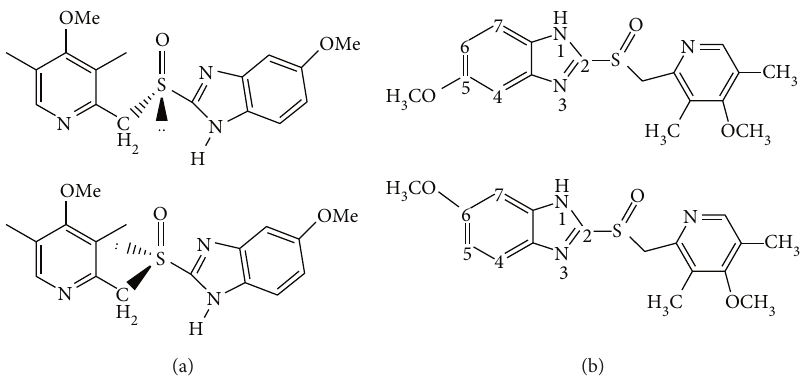
Figure 1: Enantiomers (a) and tautomers (b) of OMP. S (upper left molecule) and R (lower left molecule) enantiomers of OMP. 5-Methoxy OMP (upper right) and 6-methoxy (lower right) tautomers of